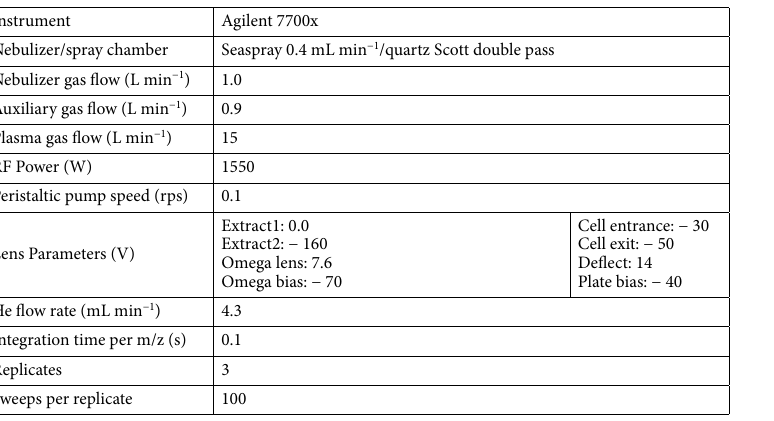
Table 2. Operating instrumental conditions of